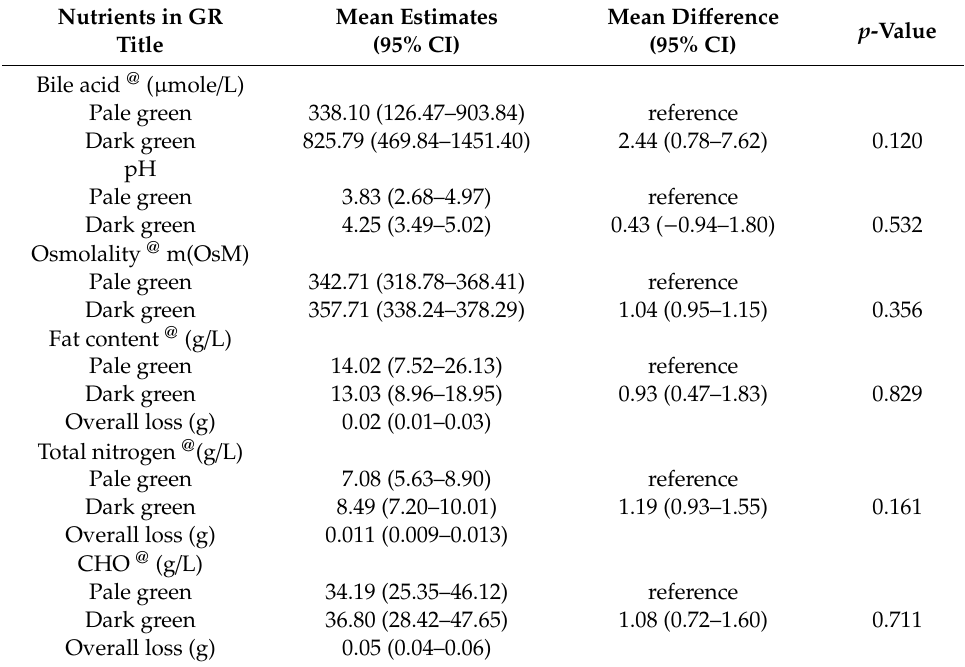
Table 3. Analysis of Gastric Residual compared between pale and dark green colour